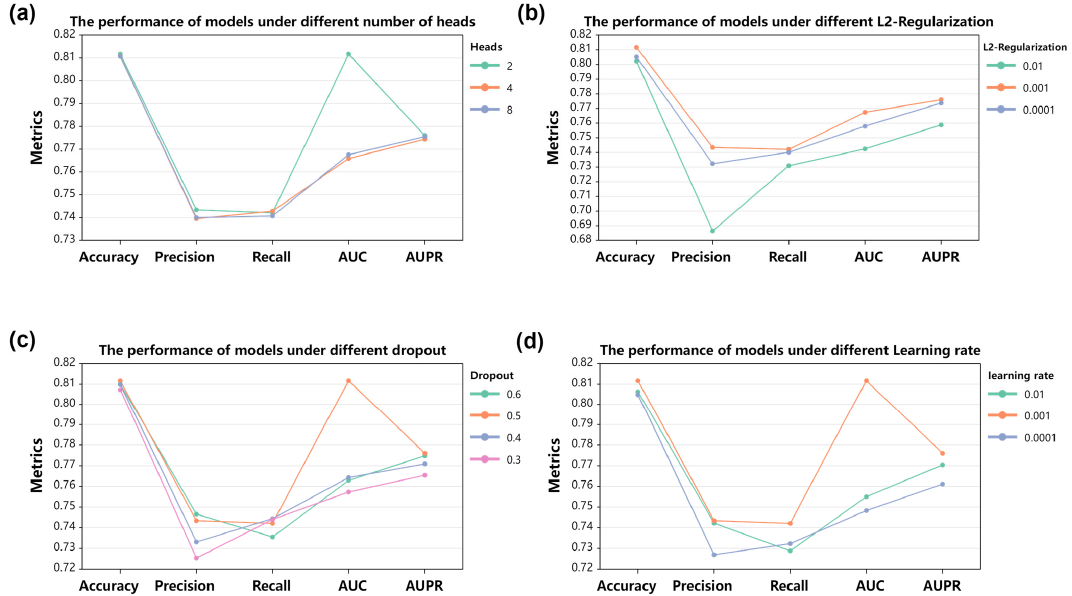
Figure 1. Model performance with different hyperparameter settings. (a)The performance of models under different number of heads. (b) The performance of models under different L2-Regularization. (c) The performance of models under different dropout. (d) The performance of models under different Learning rate.